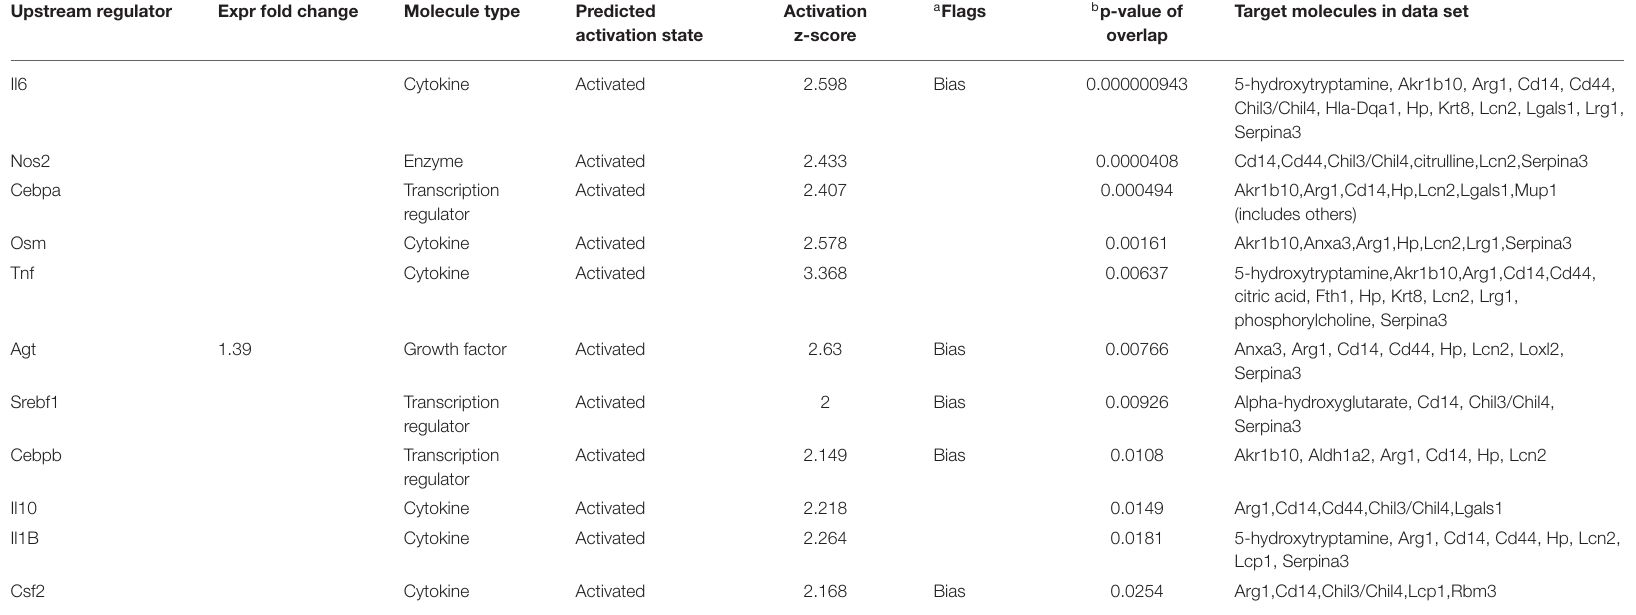
TABLE 1 | Upstream regulators for proteins and metabolites, which showed over 2-folds between the Crystal group and Control group ( z -score > 2). Upstream